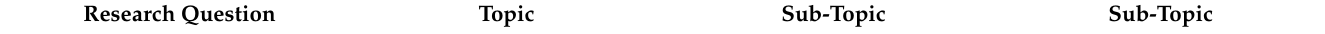
Table 1. Organization of the